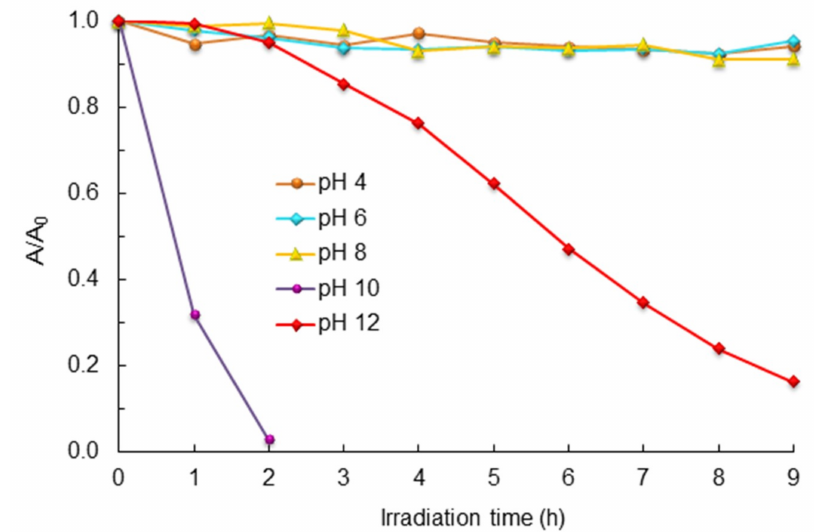
Figure 8. Photocatalytic degradation of Reactive Violet 5 (RV5) at di ff erent pH values (c 0 RV5 = 30 ppm; catalyst load = 3 g / L). A is the absorbance of the dye solution at 560